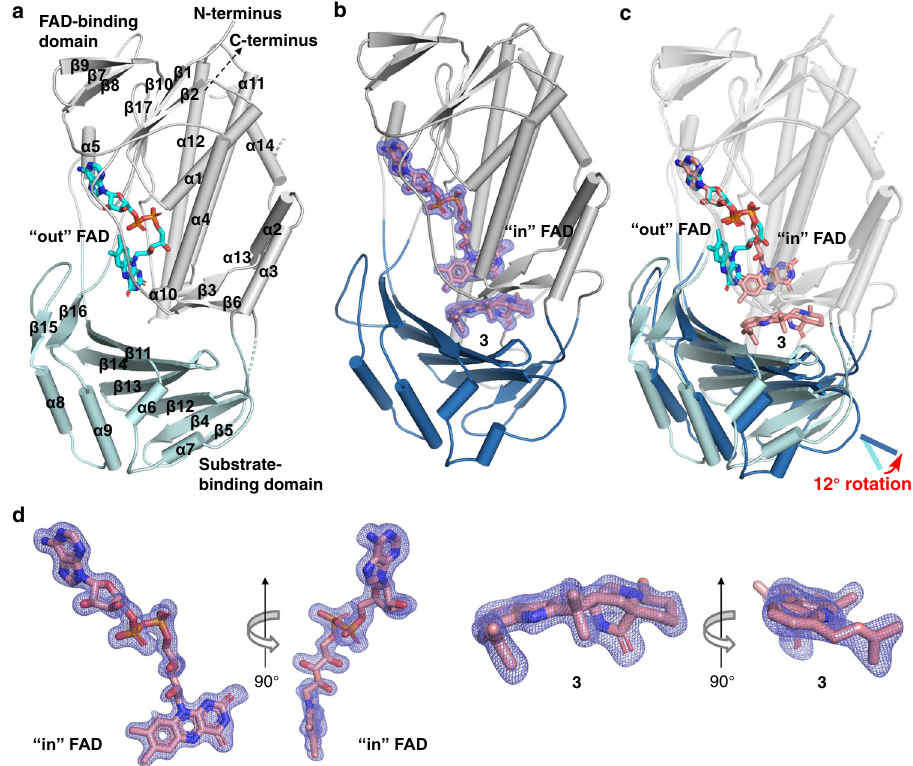
Fig. 3 The overall CtdE crystal structures and structural comparisons. a The overall structure of the CtdE – FAD complex shown in a cartoon model with two domains (gray and pale cyan), and an FAD (cyan carbons and shown in a stick representation) in the “ out ” conformation. b The overall structure of the CtdE – FAD- 3 complex is shown in a cartoon model with two domains (gray and sky blue). The simulated annealing omit map (slate mesh, F o – F c , contoured at 3.0 σ ) indicates binding of “ in ” FAD and 3 (pink carbons and shown in a stick representation) at the canonical binding site. c Superimposed CtdE – FAD and CtdE – FAD- 3 complex structures aligned with FAD-binding domains (gray), show the different conformations of substrate-binding domains (pale cyan and sky blue, respectively). Aligned FAD molecules are respectively in the “ out ” and “ in ” conformations (cyan and pink carbons, respectively, are shown in a stick representation). d The simulated annealing omit maps of the “ in ” FAD and 3 as shown in Fig. 3b.